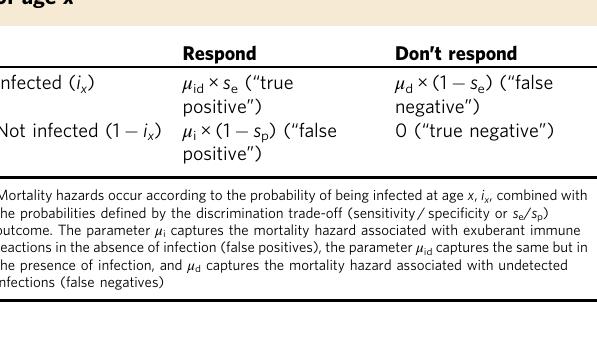
the optimal across the life-span and not within a single age class. Changes in the baseline mortality hazard or probability of infection across age, combined with the pattern of fertility over age will modulate the overall optimal strategy. Such patterns are likely to differ between the sexes, and therefore play a role in shaping the evolution of different immunological processes between the sexes. To address this, we frame the full demographic process using a Leslie matrix 35 , denoted M . We assume that survival from age x to x + 1, re fl ecting the x th column and x + 1 th row in the matrix, is de fi ned by s x (such that the proportion of individuals surviving to age A will be s 1 s 2 s 3 … × s A − 1 ); and the fi rst row of the matrix is completed to re fl ect a chosen fertility schedule, f x . The dominant eigenvalue of this Leslie matrix, λ , captures the population rate of increase and can be used as a proxy for fi tness. This framing provides a straightforward expression of the impact